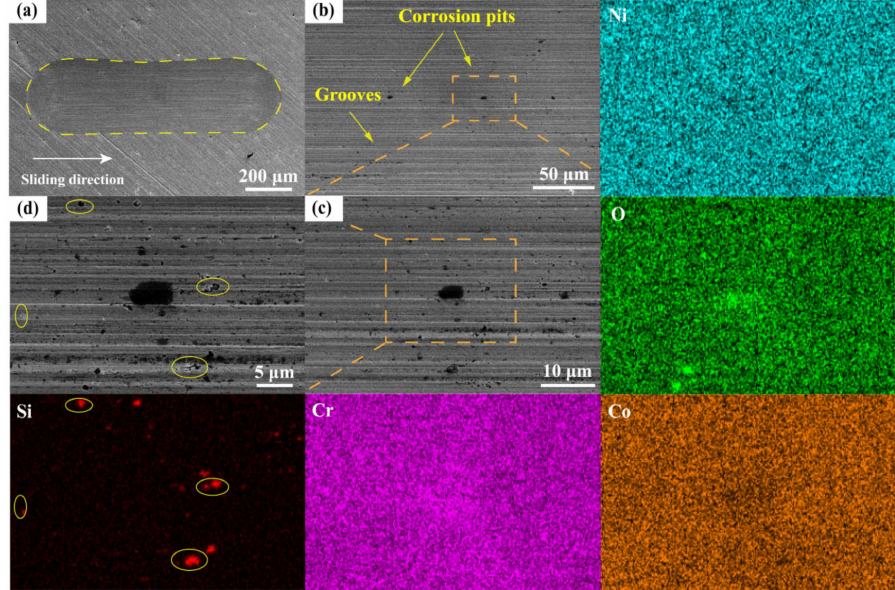
Figure 12. SEM and EDS micrographs of overall morphology ( a ) and some details ( b - d ) of the wear track for CoCrNi tested at an applied potential of 0.25